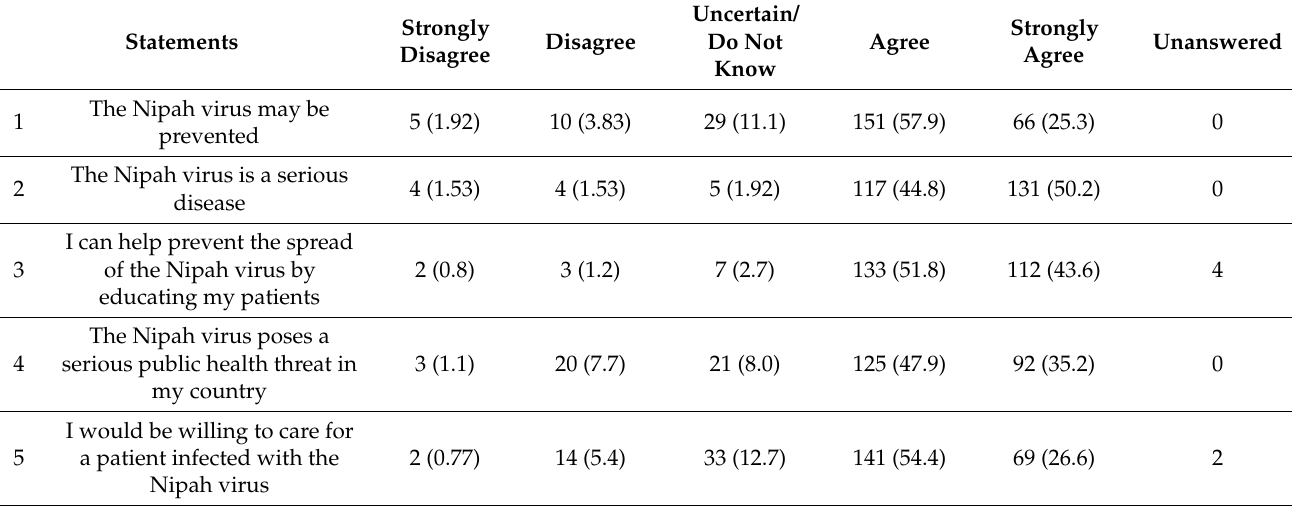
Table 4. Attitude towards Nipah